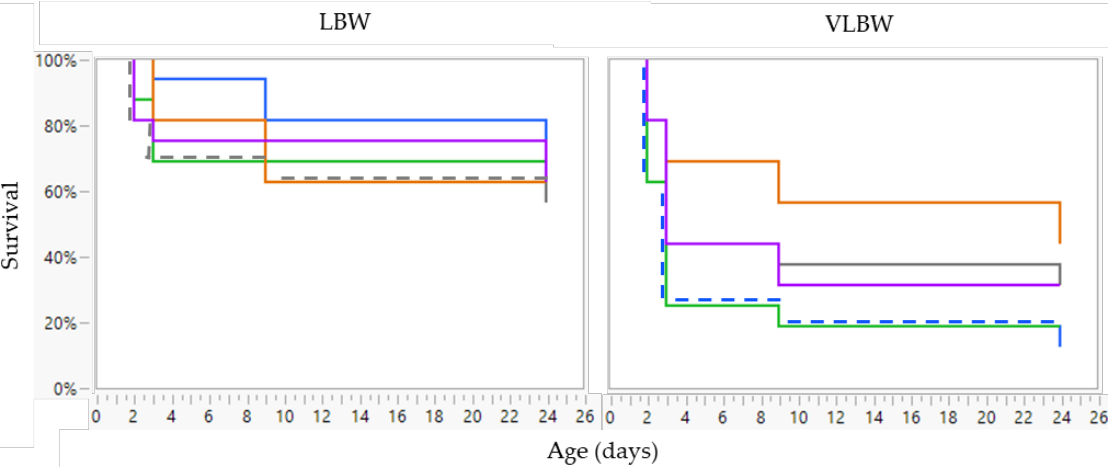
Figure 4. Cumulative mortality at Farm A of very low birth weight (VLBW; n = 80) and low birth weight (LBW; n = 80) piglets per treatment (no treatment (green line), sham 1 dose (orange line), sham 3 doses (purple line), dense milk replacer 1 dose (grey line) or dense milk replacer 3 doses (blue line)). Cox’s proportional hazard model showed that VLBW piglets had a significantly higher risk of dying than LBW piglets (Risk ratio: 2.39; p < 0.001). The animals had the greatest risk of dying during the first day after birth, with the risk decreasing over the following time points ( p < 0.001).